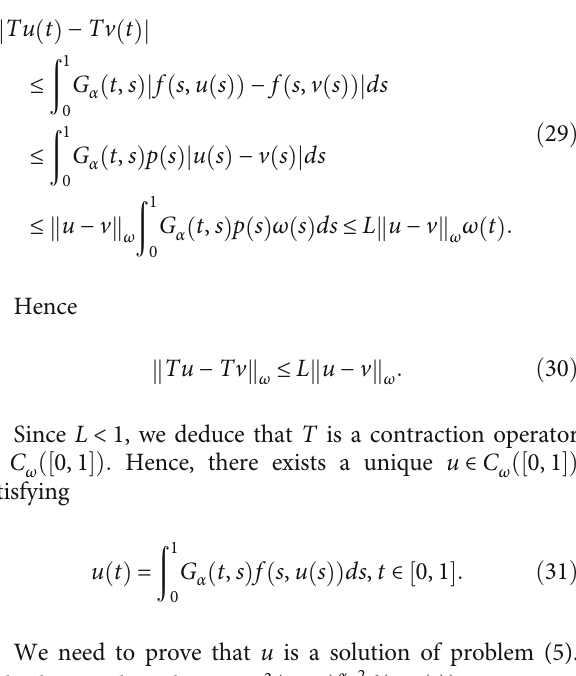
The sequences of functions u 0 ð t Þ , u 1 ð t Þ , u 2 ð t Þ , u 3 ð t Þ , and u 4 ð t Þ are illustrated in Figure